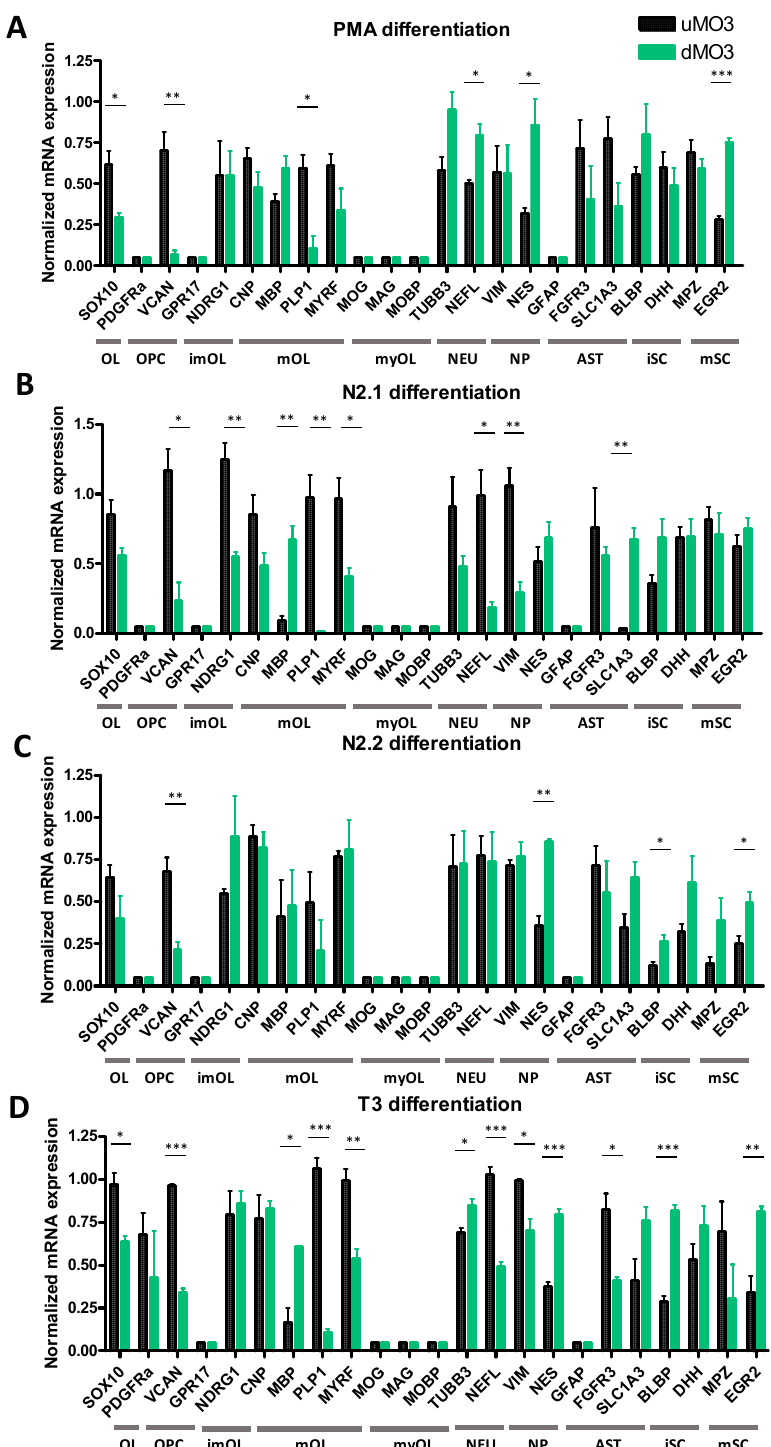
Figure 3. Normalized mRNA expression in undifferentiated MO3.13 cells (uMO3) and MO3.13 cells following differentiation (dMO3) with ( A ) PMA, ( B ) N2.1 medium, ( C ) N2.2 medium or ( D ) T3 medium. OL: oligodendrocyte lineage, OPC: oligodendrocyte precursor, imOL: immature oligodendrocyte, mOL: mature oligodendrocyte, myOL; myelinating oligodendrocyte, NEU:neuronal, NP: neural progenitor, AST:astrocyte, NP:neuralprogenitor, iSC: immature Schwann cell, mSC: mature Schwann cell. Independent samples t -tests are based on triplicates in three independent experiments ( n = 3). p -values: * < 0.05, ** < 0.01, *** <